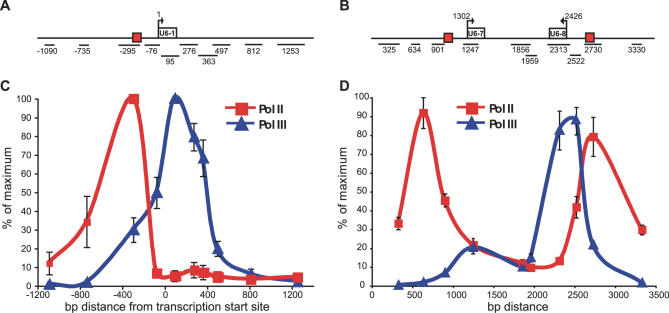
Pol II and Pol III Accumulate in Two Distinct Peaks at the U6–1, U6–7, and U6–8 Promoters(A, B) Diagrams of the U6–1 and U6–7/U6–8 gene regions, with black lines specifying the PCR amplicons identified by the central nucleotide. Boxes represent the position of the DSE. (C, D) Summary plots of ChIP experiments with Pol II and Pol III distributions on U6–1 gene region (C) and U6–7 and U6–8 (D). Crosslinked pemHeLa extracts were used for ChIP with primers amplifying fragments distributed 1 kb upstream and downstream of each gene. Antibodies specific for Pol II (4H8) and Pol III were used. X-axis values in (C) are relative to the U6–1 transcription start site at position +1, whereas transcription start sites in (D) are at +1,302 (U6–7) and +2,426 (U6–8), relative to an arbitrary point upstream of U6–7. Data points are placed according to the center positions of the PCR products along the region. The peak value for the region (either U6–1 region or U6–7/U6–8 region) was determined for each biological replicate and set to 100%; displayed values are averaged among at least three biological replicates. Error bars represent the SEM.